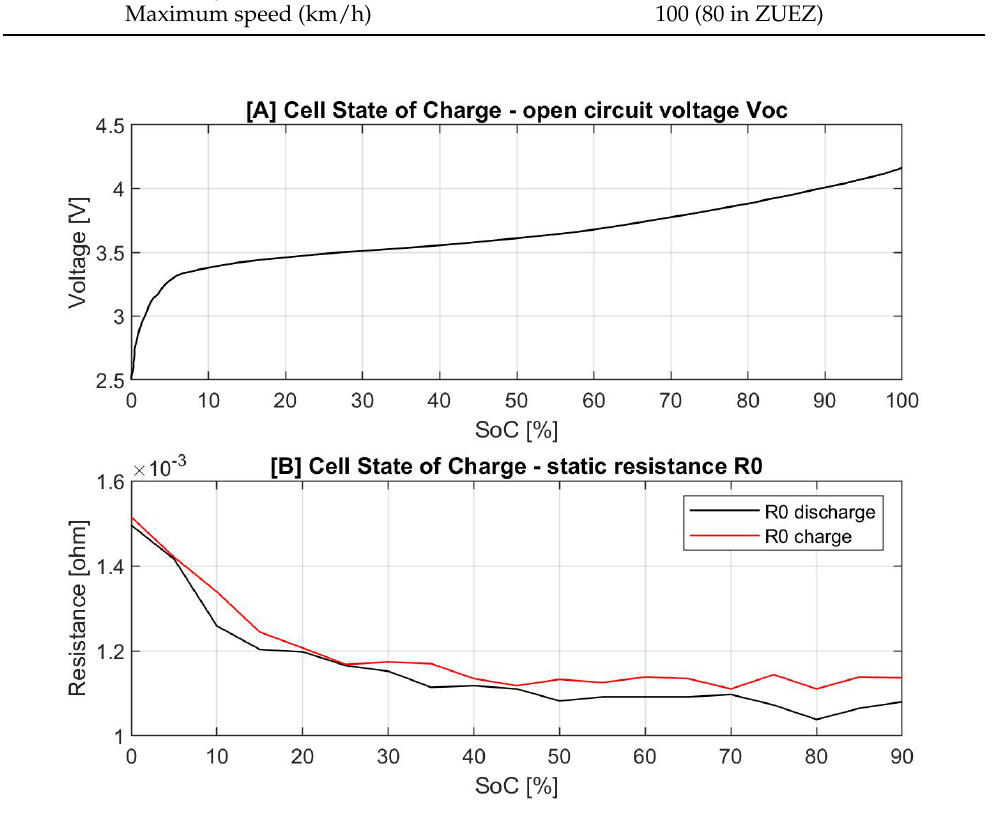
Figure 1. Li-ion NMC cell ( A ) open circuit voltage and ( B ) charge/discharge static